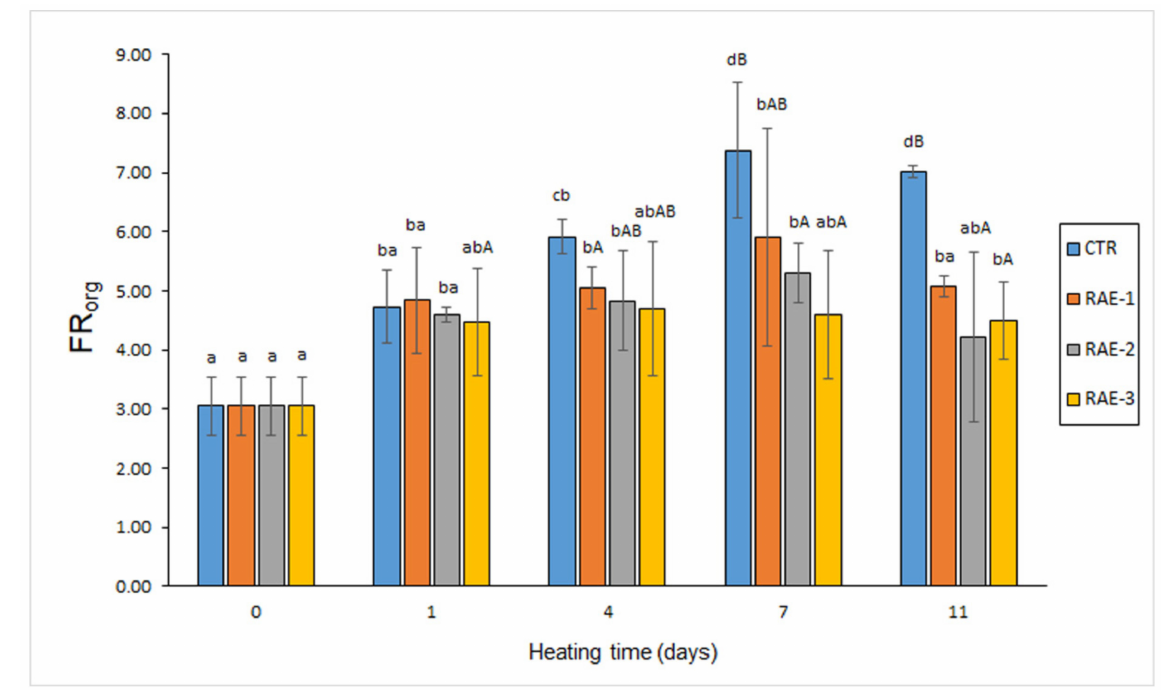
Figure 1. The evolution of fluorescent compound content in the lipid extract of fish muscle (FR org ) heated in the presence of red alga extract (RAE). Abbreviations of RAE concentrations are as expressed in Table 1. Mean values of three independent determinations ( n = 3); standard deviations are shown by bars. Mean values accompanied by lowercase (a–d) letters denote significant differences ( p < 0.05) as a result of heating time; mean values accompanied by capital letters (A,B) denote significant differences ( p < 0.05) as a result of RAE